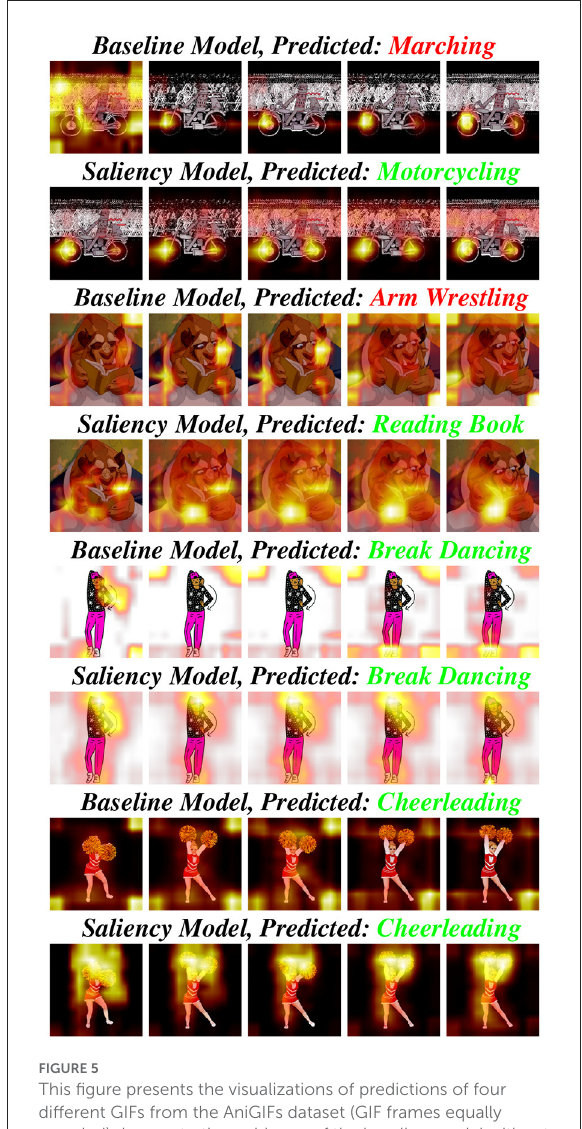
FIGURE5 This figure presents the visualizations of predictions of four different GIFs from the AniGIFs dataset (GIF frames equally sampled) demonstrating evidence of the baseline model without domain generalization and the model trained with the explainability-based domain generalization approach (Section 4.2). The top two examples show that for some GIFs the explainability approach boosts both the model accuracy and generalization ability. And the bottom two examples show that even when making a correct prediction, the baseline model does not use discriminative cues to make that prediction. In contrast, the model trained with the explainability-based domain generalization approach accurately highlights the correct action-specific